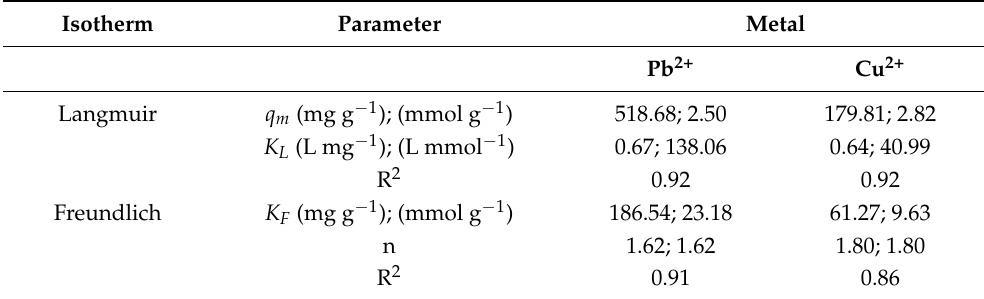
Figure 3. Langmuir and Freundlich adsorption isotherm models ( a ) in mg g − 1 and ( b ) in mmol g − 1 for the adsorption of Pb 2+ and Cu 2+ onto PAM@MNP. Symbols represent the experimental data. Initial concentration: 0.5–70 mg L − 1 ; adsorbent concentration: 0.2 g L − 1 ; pH: 6; temperature: 20 ◦ C; contact time: 24 h. Table 2. Langmuir and Freundlich isotherm parameters for the adsorption of Pb 2+ and Cu 2+ onto PAM@MNP.